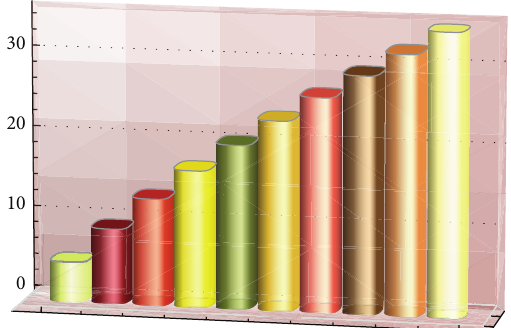
Figure 5: A log scale of solution size against choices of blanks.